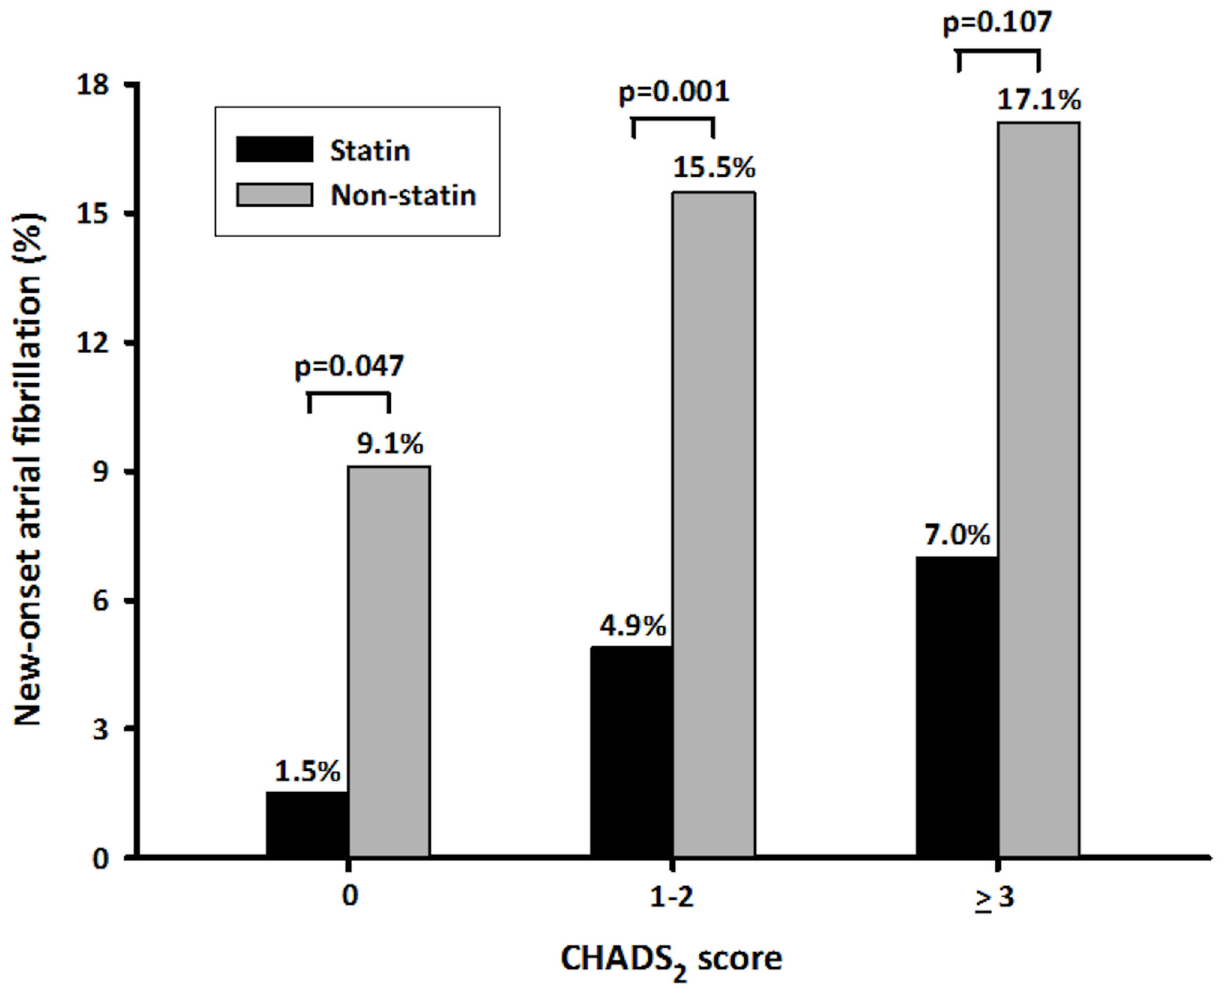
Figure 2. Relationship between CHADS